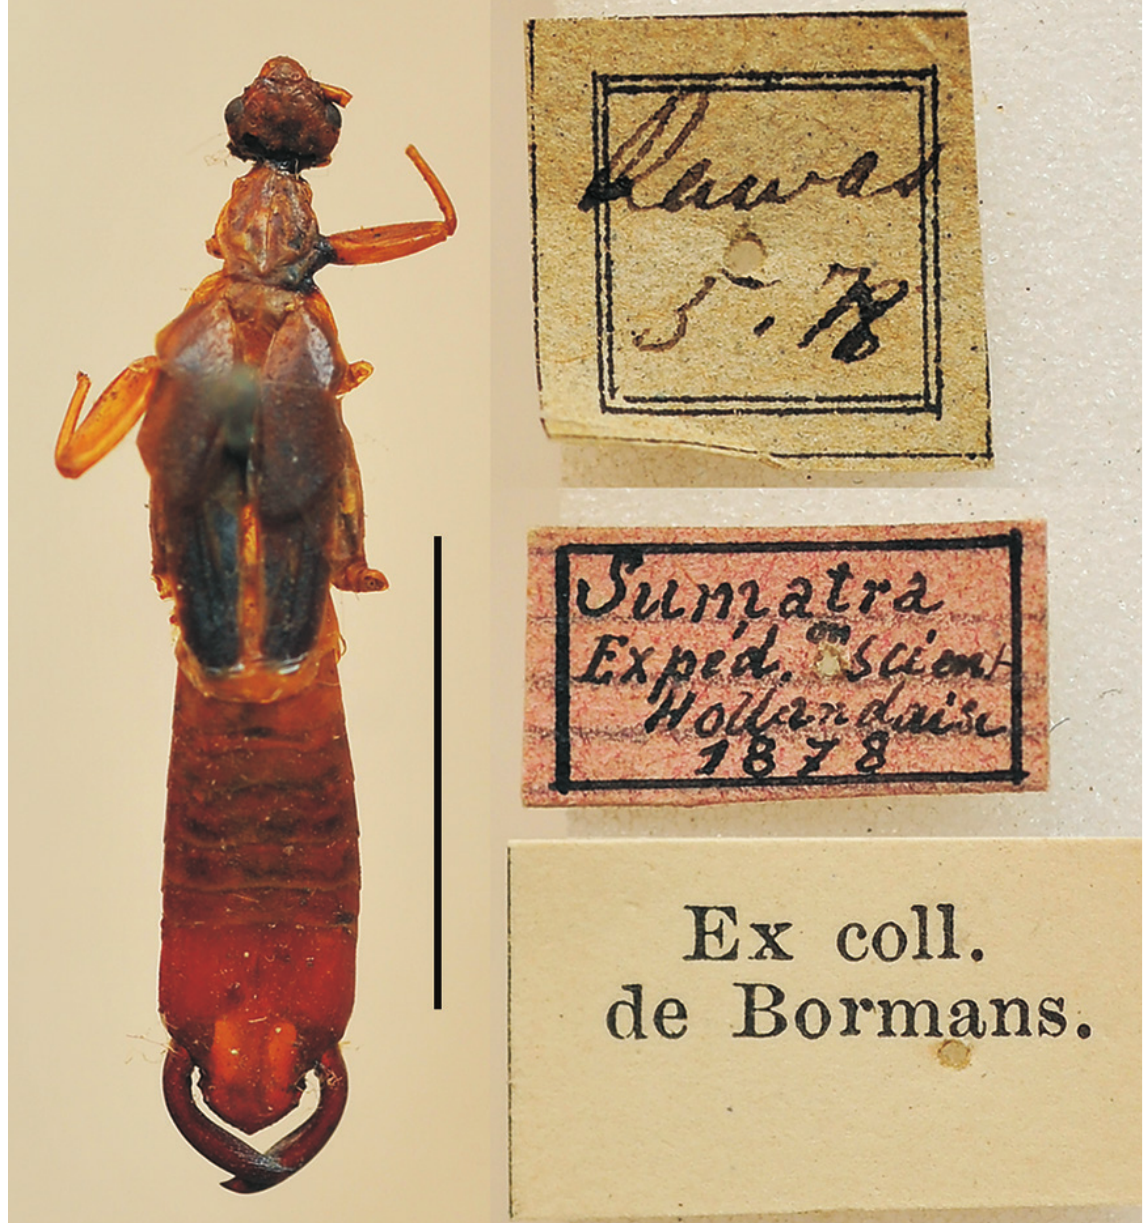
Fig. 5. The collection’s earliest dated specimen, Apachyus chartaceus (Haan, 1842), dated 1878, the Manchester Museum. Scale bar = 1